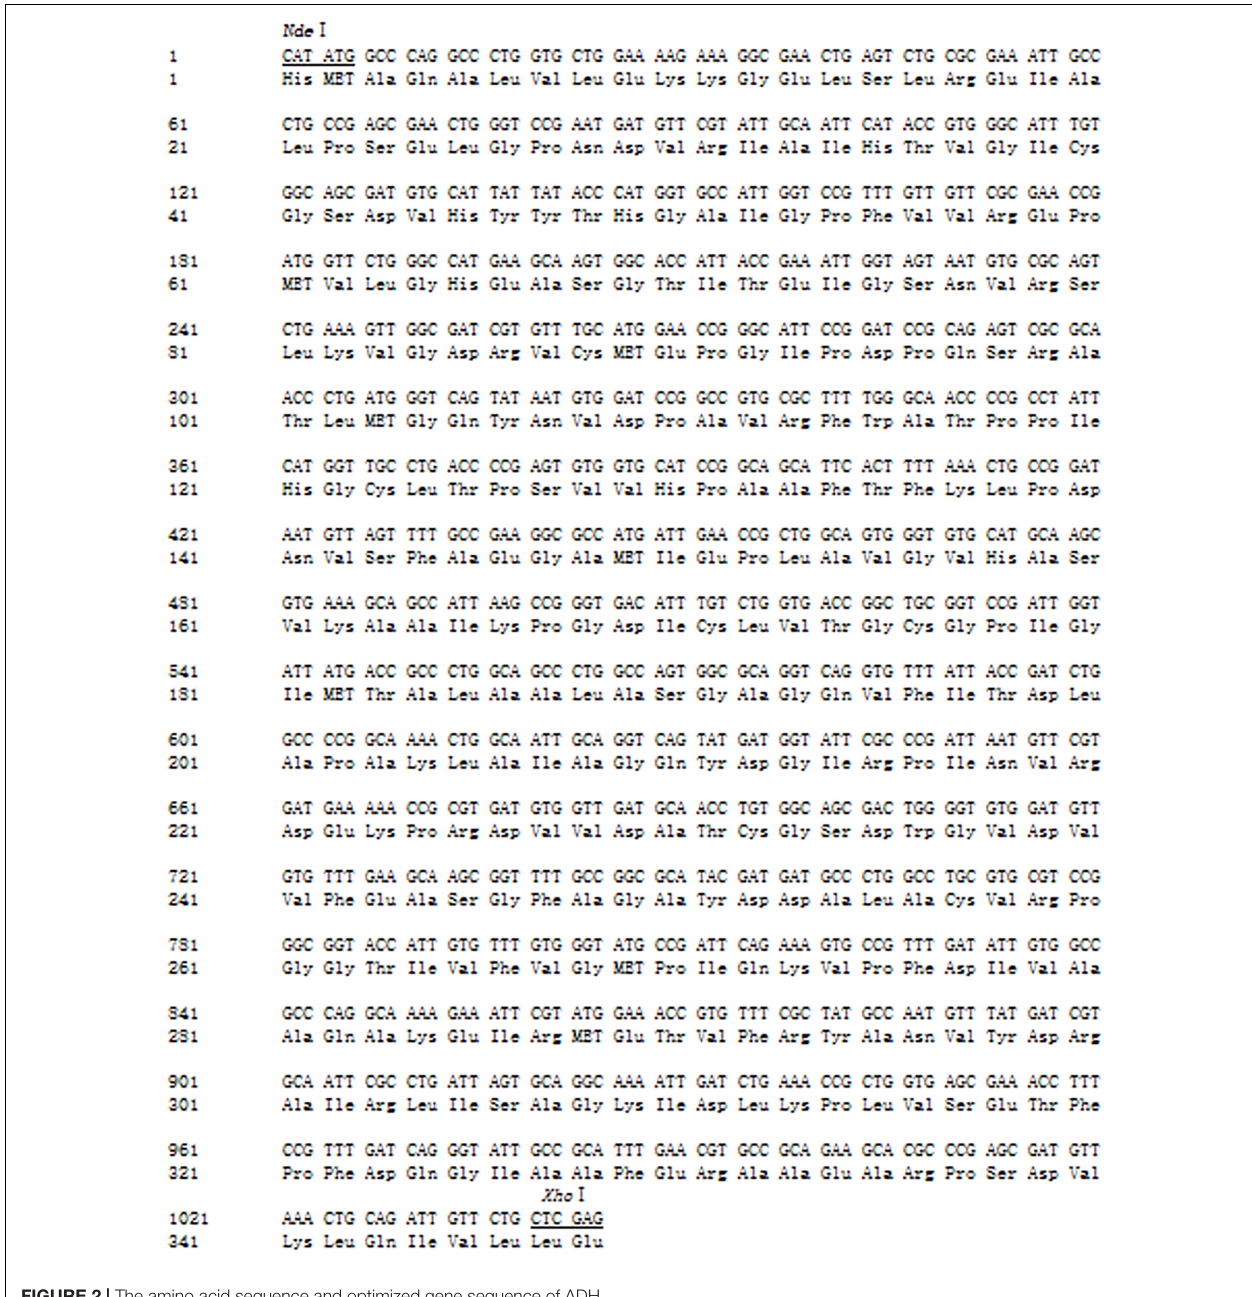
FIGURE 2 | The amino acid sequence and optimized gene sequence of